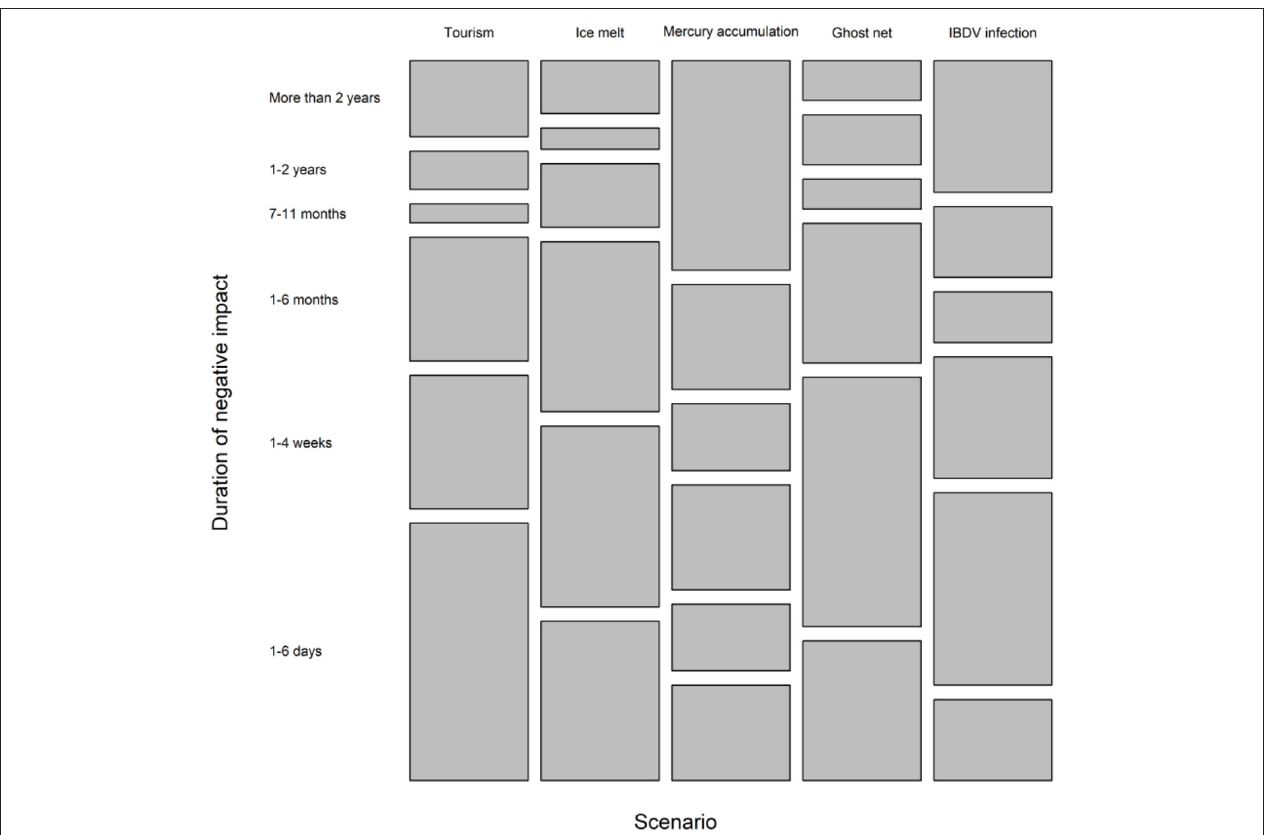
FIGURE 4 | Percentage of responses given for the duration of negative impact for each scenario.